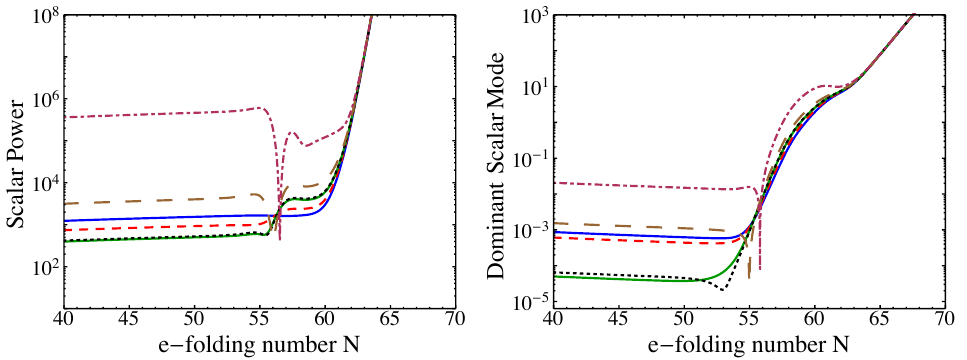
Figure 10 . Left: the scalar power for (cid:13) = 7 and M = 0 ; 1 ; 1 : 5 ; 1 : 55 ; 2 ; 3 (blue solid, red dashed, green solid, black dotted, brown long-dashed and maroon dot-dashed respectively). Right: the dominant \slow" mode-function e (cid:0) ( N (cid:0) N (cid:3) ) j (cid:1) 2 ( N ) j for the same parameters and color-coding. not seen in the related model of Higgsed Chromo-Natural In(cid:13)ation [26]. However, in that work the region of parameter space corresponding to the (Higgsed) Gauge-(cid:13)ation model was not